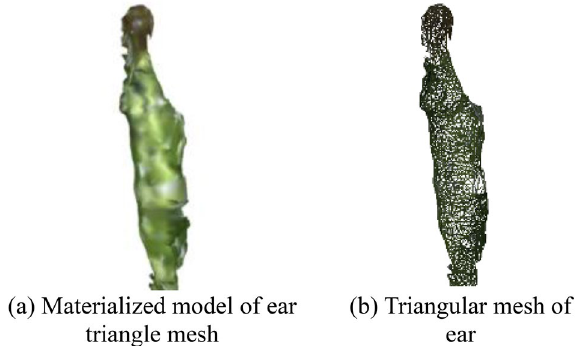
Figure 16. Triangular mesh results of ear.